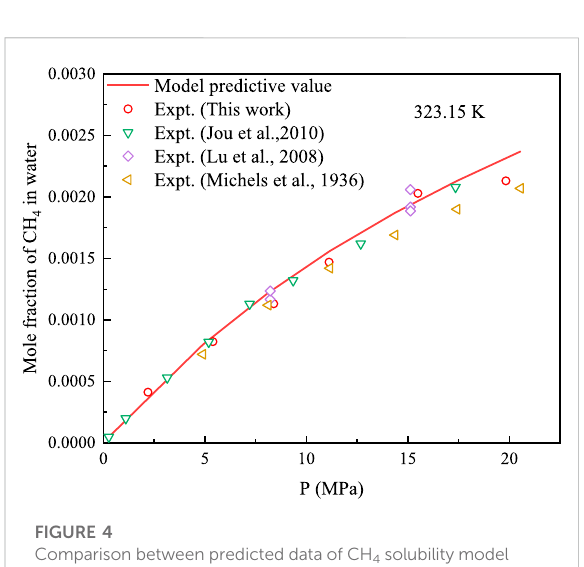
FIGURE 4 Comparison between predicted data of CH 4 solubility model and experimental data at 323.15 K.